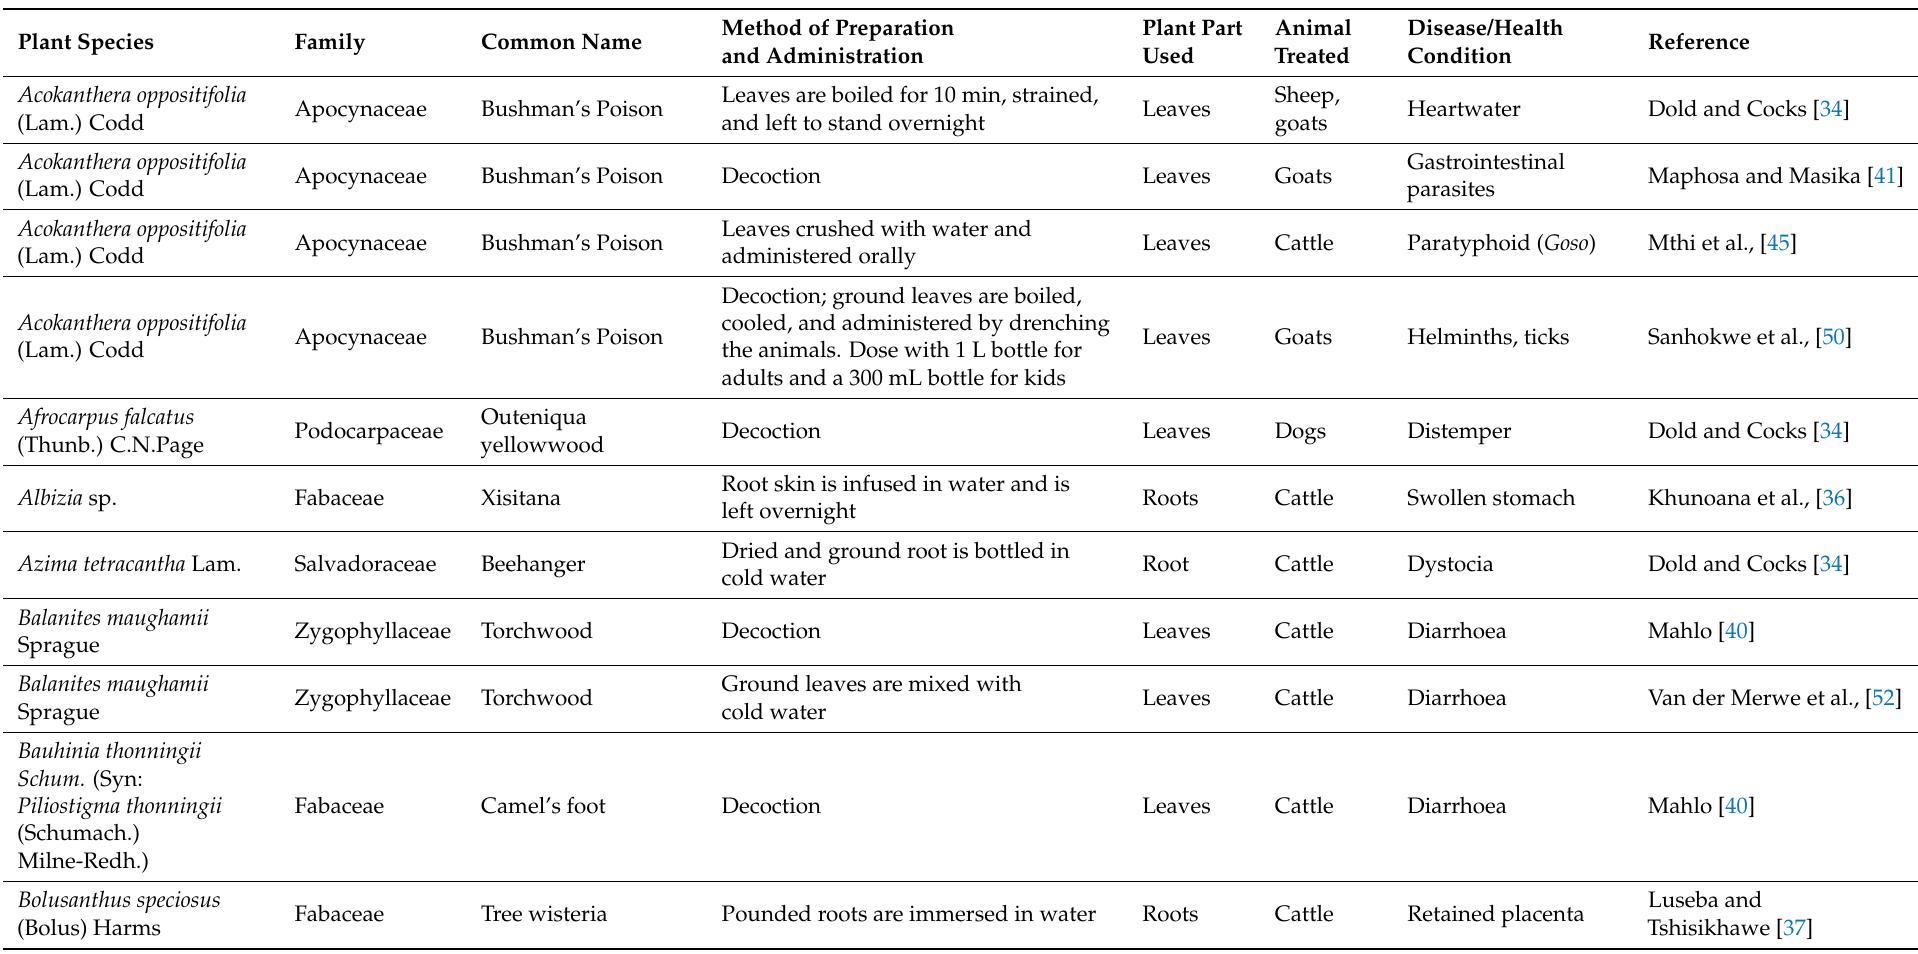
Table 2. Inventory of woody plants used for ethnoveterinary purposes among communities in South Africa. Botanical names were validated using PlantZAfrica (http://pza.sanbi.org/ (accessed on 29 September 2021)), The Plant List (http://www.theplantlist.org/ (accessed on 29 September 2021)), and The World Flora Online (http://www.worldfloraonline.org/ (accessed on 29 September 2021)). Syn = synonym; ns = not